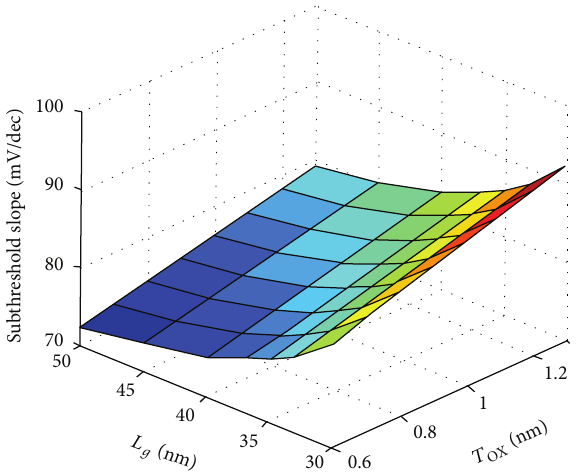
Figure 6: Subthreshold slope as a function of 𝐿 𝑔 and 𝑇 OX for 45 nm NMOS.